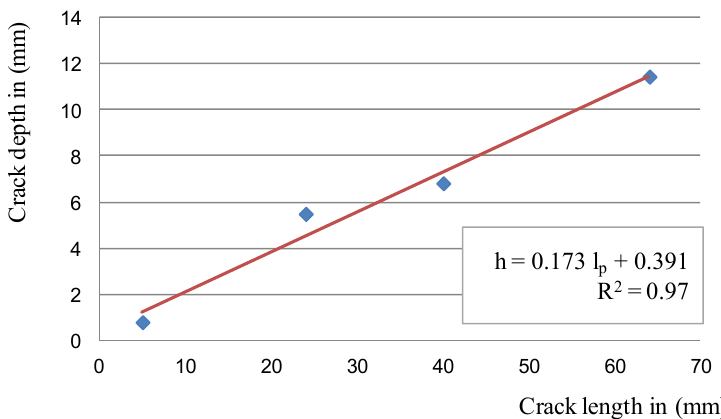
Figure 15. The dependence of the depth of the crack on its length; blue—depths determined from the regressive functions of circles, red—linear dependence of the crack depth on its length.